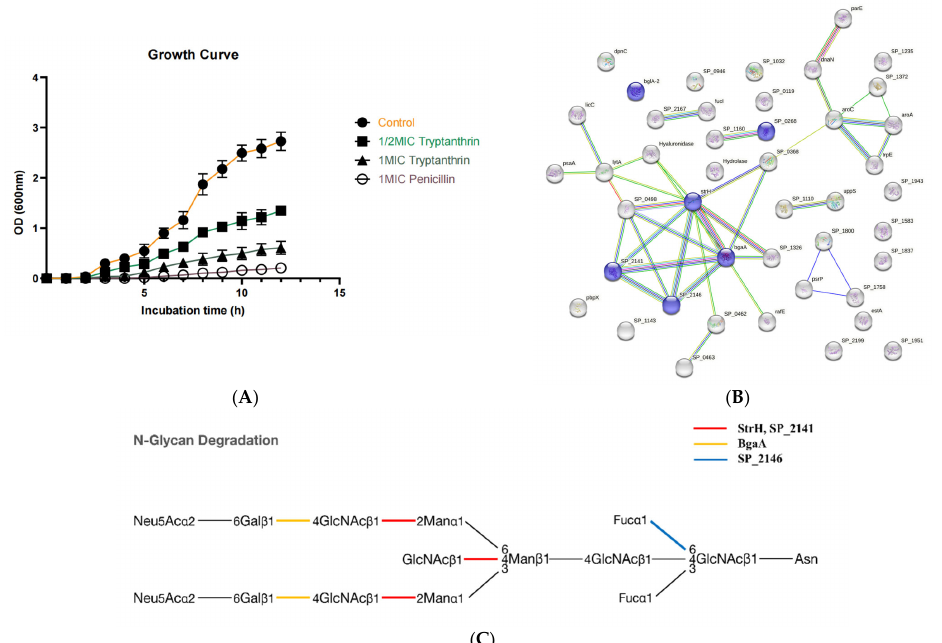
Figure 4. Antibacterial activity of Tryptanthrin isolated from S. cusia leaves. ( A ) Growth curve of F3983 treated by Tryptanthrin at 1/2× and 1× MIC. ( B ) A protein–protein interactions (PPI) network map of the selected targets. Proteins, which belong to the Glycoside hydrolase superfamily, are denoted as purple circles. ( C ) A KEGG pathway enrichment analysis for the selected targets. The red lines represent the enzymes strH and SP_2141, which release the GlcNAc; the yellow line implies the enzyme bgaA, which releases the galactose; the blue line designates the enzyme SP_2146, which releases the fucose.